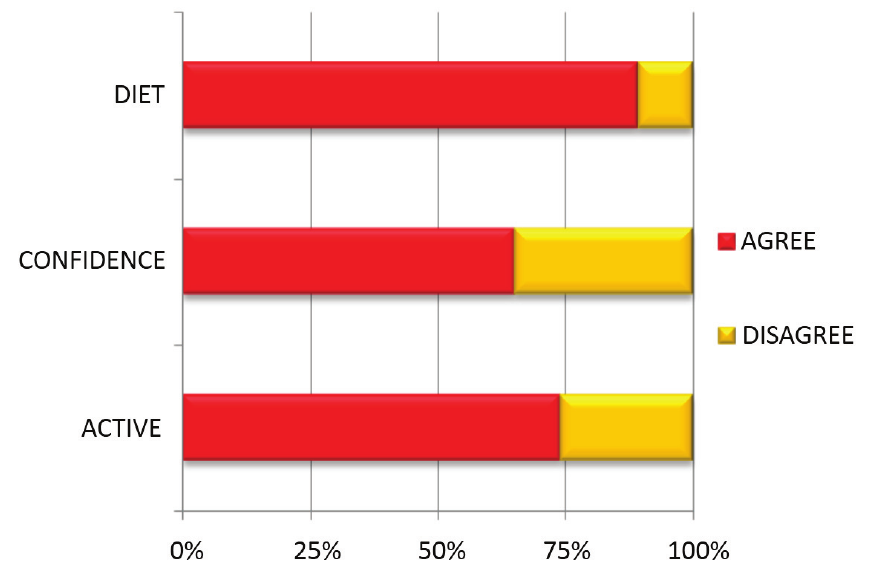
Figure 2. Percentage of respondents having made lifestyle